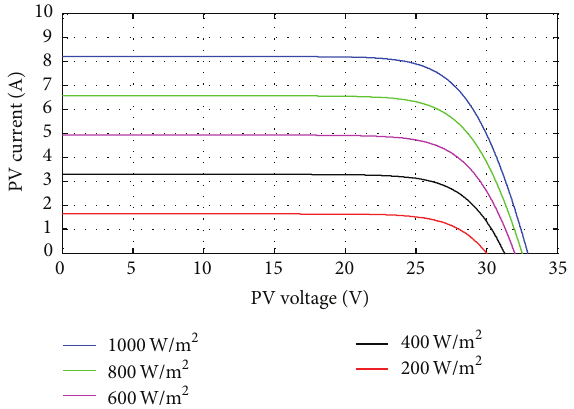
Figure 5: Voltage waveform of the boost converter’s inductor.